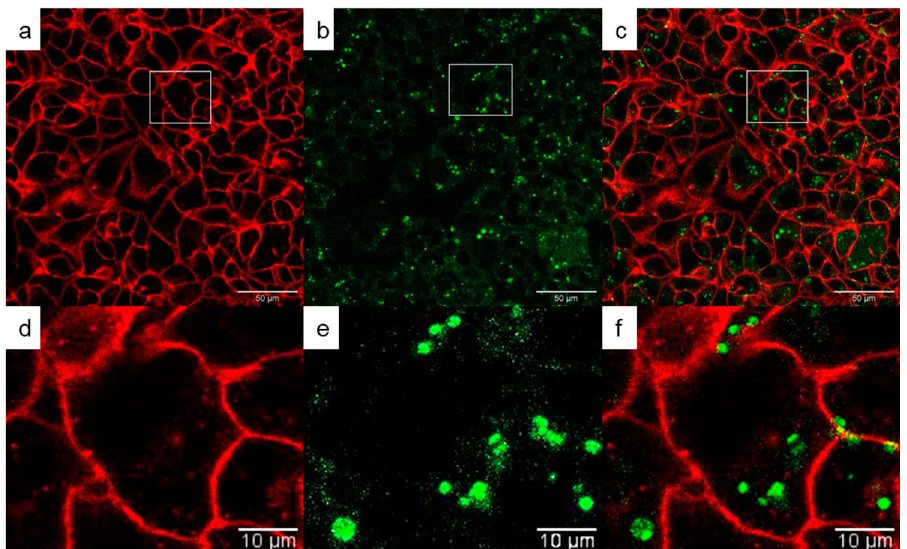
Figure 7. ( a – f ) Confocal micrographs of distribution of GdF 3 :Tb 3+ ,Yb 3+ ,Nd 3+ @P(DMA-AGME)-Ale nanoparticles in HepG2 cells at 808 nm excitation with a laser power of 30–50 mW. ( d – f ) Detailed micrographs of ( a – c ). ( a , d ) CellMask™ deep red-stained cell membrane, ( b , e ) nanoparticles (green), and ( c , f ) overlay of ( a , b ) and ( d , e ), respectively. Table 2. Relaxometry of aqueous Gd(Tb)F 3 :Tb 3+ (Gd 3+ ),Yb 3+ ,Nd 3+ @P(DMA-AGME)-Ale nanoparticle dispersions measured at 23 ◦